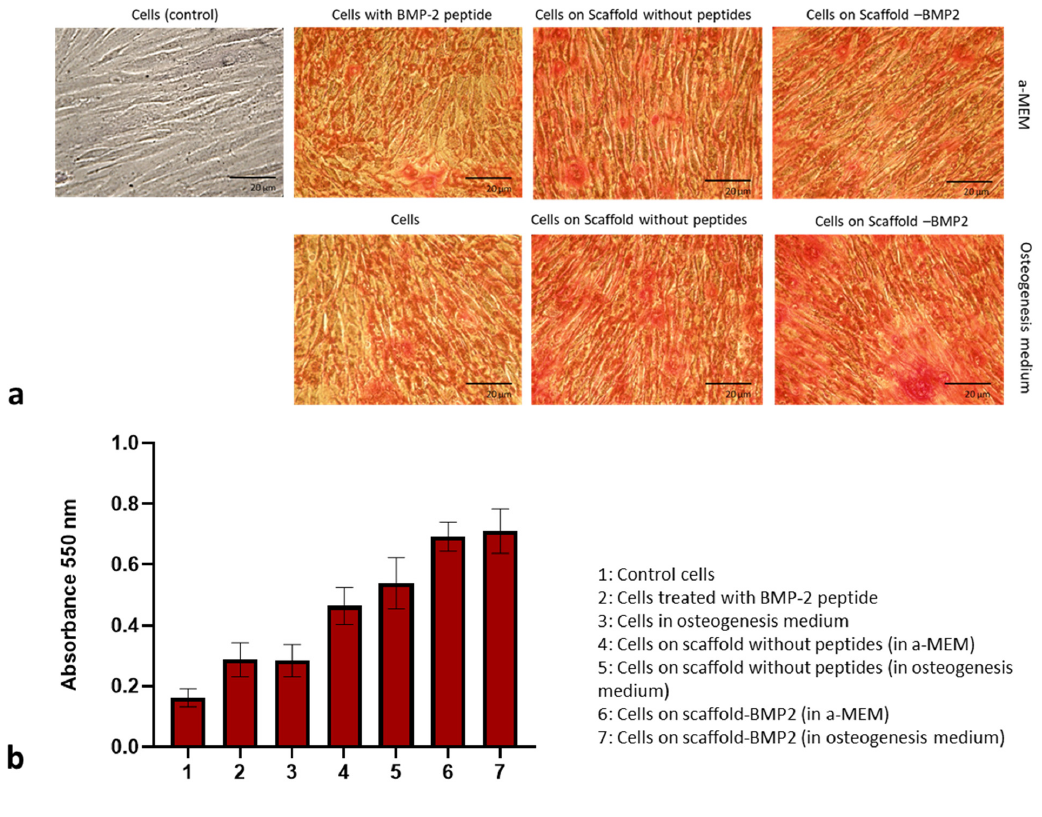
Figure 10. ( a ) Detection of calcium deposits in the extracellular matrix by Alizarin Red staining after 21 days of culture of hDPSCs on scaffolds and without scaffolds. The photographs were taken at 10× g magnification with a Nikon DS-Fi3 microscope camera, and 20 μ m-scale bars have been in- cluded. ( b ) Quantification of Alizarin Red staining at 21 days. Optical absorption was measured at 550 nm with a microplate reader (Biotek Plate Reader).